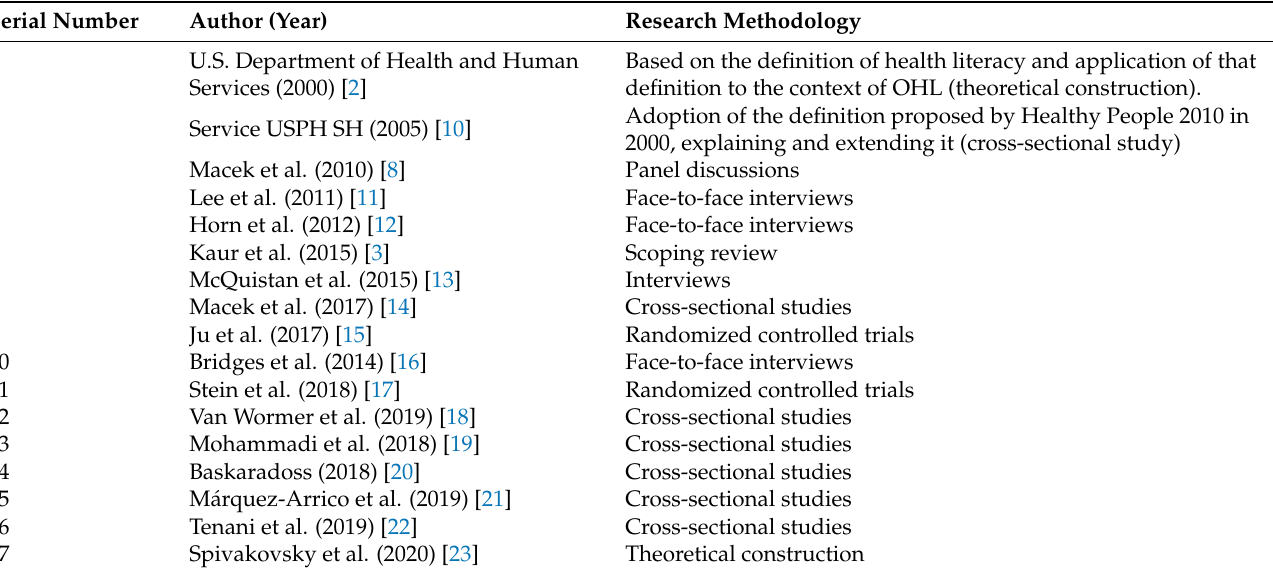
Table 2. Summary of methodological information included in the OHL